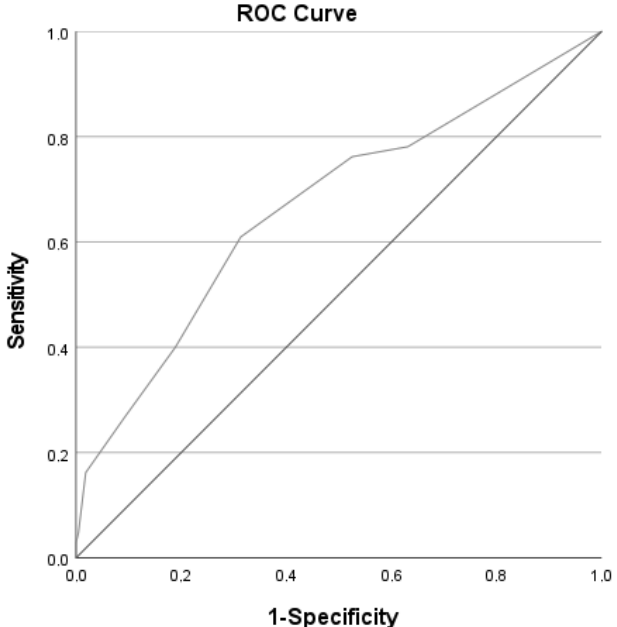
Figure 3. Receiver Operating Characteristic (ROC) curve ( n = 322) of the Ingesta-verbal/Visual analogue Scale (ingesta-VVAS) to predict energy intake, calculated by a 24-h recall, <75% of Total Energy Expenditure (TEE) (Area under the ROC curve = 0.668, 95% CI 0.603–0.733). TEE is calculated by the World Health Organization 1985 formula [21] (BMI ≤ 30 kg/m 2 ) or Harris & Benedict 1918 formula [23] (BMI > 30 kg/m 2 ), both with an addition of 30% for physical activity/disease activity. CI, confidence interval. Table 2. Performance of the Ingesta-verbal/Visual analogue Scale (ingesta-VVAS) to predict energy intake <75% of Total Energy Expenditure (TEE) ( n = 322). Energy Intake Total ( n ) <75% of TEE ≥ 75% of TEE